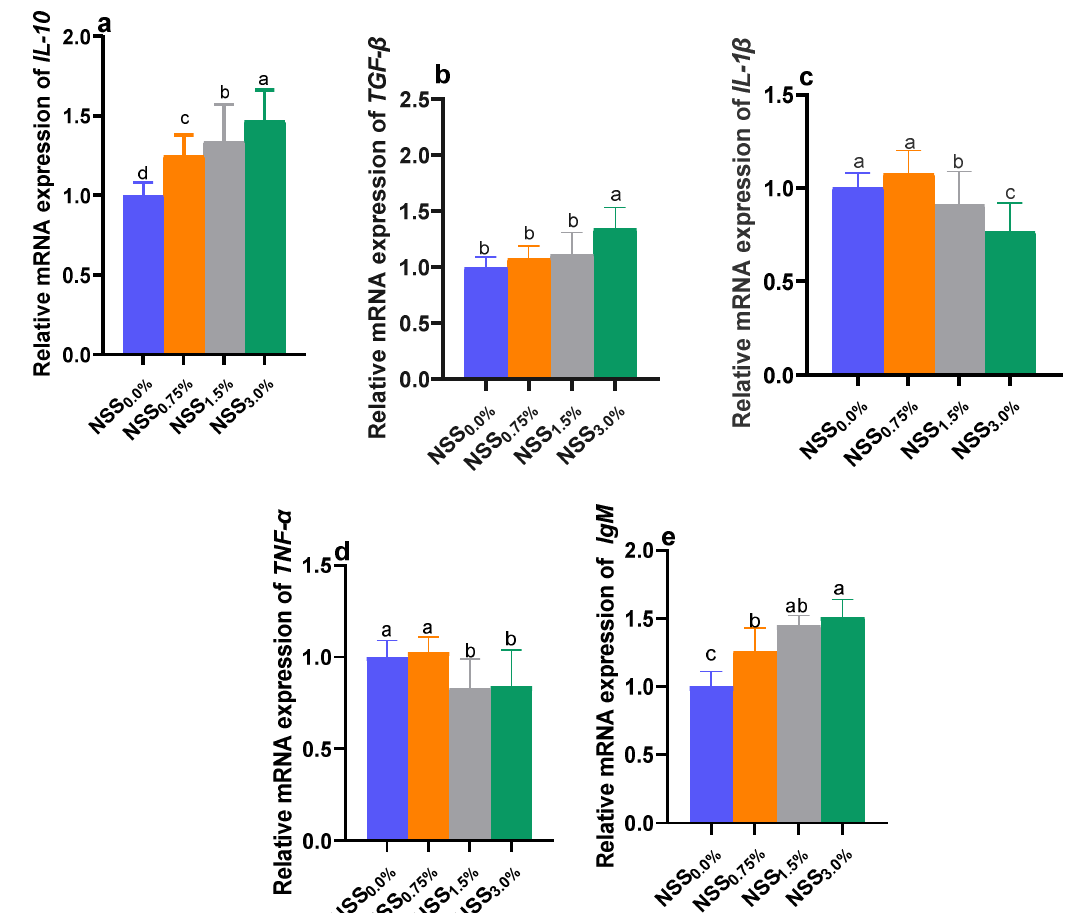
Figure 2. Effect of supplementing diets with varying levels of a microalgae mix (NSS) containing Nannochloropsis oculate and Schizochytrium and Spirulina species at equal proportions (1:1:1) for 12 weeks on relative expression of interleukin (IL) - 10 ( a ), transforming growth factor beta; TGF - β ( b ), IL - 1 β ( c ), tumor necrosis factor alpha; TNF - α ( d ) and Immunoglobulin M; IgM ( e ) genes in Nile tilapia spleen. Data are expressed as means ± SE. Bars with different letters denote significant differences ( p < 0.05). NSS: microalgae mix containing Nannochloropsis oculate and Schizochytrium and Spirulina species at equal proportions (1:1:1), NSS 0.0% : control group fed basal diet free from NSS, NSS 0.75% : basal diet supplemented with 0.75% of NSS, NSS 1 . 5% : basal diet supplemented with 1.5% of NSS , NSS 3 . 0% : basal diet supplemented with 3% of NSS.